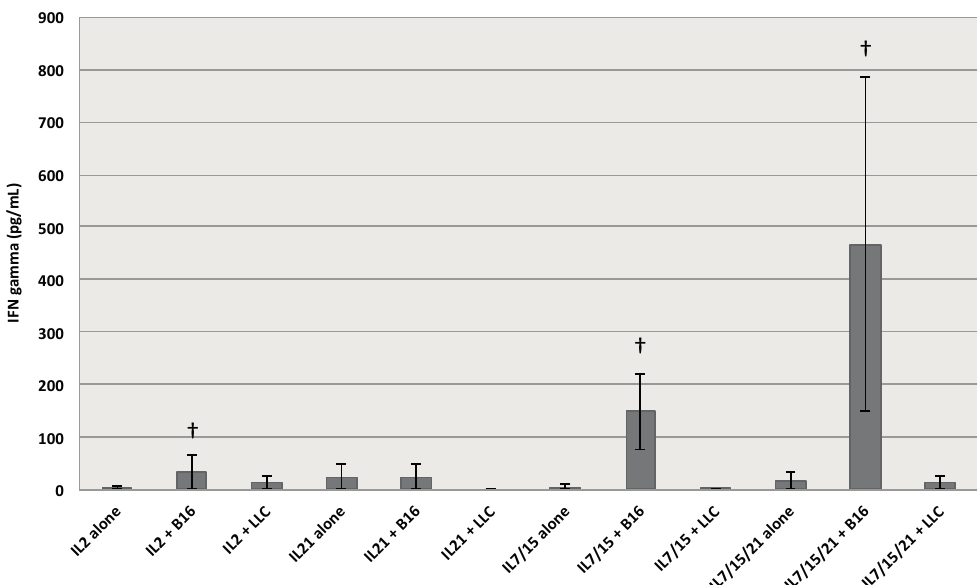
Figure 5. Interferon-gamma ELISA assay. B/I pulsed and IL-2, IL-21, IL-7/15 and IL-7/15/21 exposed spleen-derived T cells were co-cultured with B16 melanoma cells, Lewis lung carcinoma (LLC) cells or media alone for 24 h. The amount of IFN- γ release was significantly higher in the group exposed to IL-7/15/21 and approached significance in the group exposed to IL-7/15 than for spleen-derived T cells expanded in IL-2 or IL-21 and co-cultured with B16 cells, † ( vs . IL2+B16) 9 = p < 0.04 (IL-7/15/21), p = 0.06 (IL-7/15). 2.4. Treatment of B16 Melanoma Metastases with Lymphocytes Exposed to Different Cytokines Compared to the control group, mice treated with cyclophosphamide alone or cyclophosphamide plus AIT with the standard dose of spleen-derived lymphocytes (10 million cells/mouse) expanded for 7 days in IL-2, IL-7/15 or IL-7/15/21 exhibited significantly fewer metastatic lung nodules (Figure 6a) ( p = 0.0369, p = 0.0330, p < 0.0001, p < 0.0001). At this dose of cells, IL-7/15 and IL-7/15/21 expanded cells were significantly better at curing metastases than cyclophosphamide alone ( p < 0.0001, p < 0.0001), whereas IL-2 expanded cells were not more effective than CYP alone ( p = 0.49). However, only the IL-7/15/21 expanded cells were significantly better than cyclophosphamide alone for curing metastases at a lower dose of T cells (2 million cells per mouse) ( p = 0.002). In addition, when compared to AIT with 10 million cells grown in IL-2 (the current standard), IL-7/15 and IL-7/15/21 expanded cells were significantly better at curing metastases at the same cell dose (10 million) ( p < 0.0002, p < 0.0007), with the majority sustaining complete cures (zero metastases seen). In our experiments, we found that AIT with cells expanded in IL-21 alone, whether at 10 million or 2 million cells, was not statistically significantly different from the control or CYP groups ( p = 0.27, p = 0.59). A similar experiment was performed with DLN-derived lymphocytes (Figure 6b). Both IL-7/15 and IL-7/15/21 expanded lymphocytes were significantly better than control at the lower dose of AIT (two million cells) at curing melanoma metastases ( p = 0.002, p = 0.004). However, at the standard dose of ten million cells both IL7/15 an IL7/15/21 expanded cells were capable of curing metastases significantly better than control, CYP only, and both groups at the two million cell dose ( p <